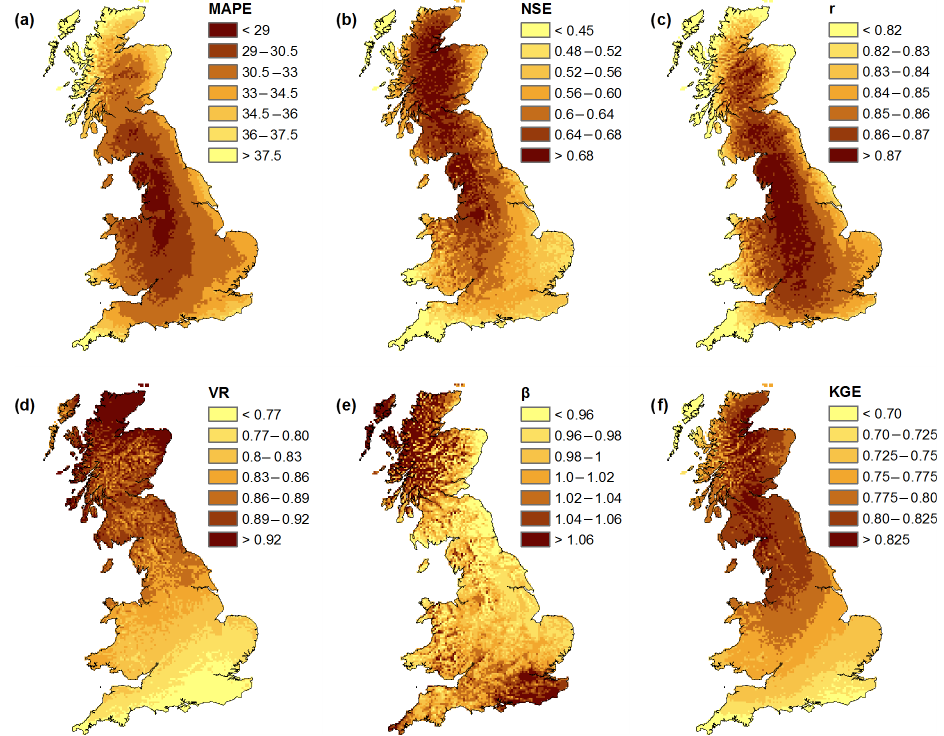
Figure 5. Grids of evaluation metrics for the new daily gridded PET dataset. The darker the colour, the better the performance for all metrics represented, except for the bias ratio ( β ) (e) where the middle-range colour is optimal (see Sect.